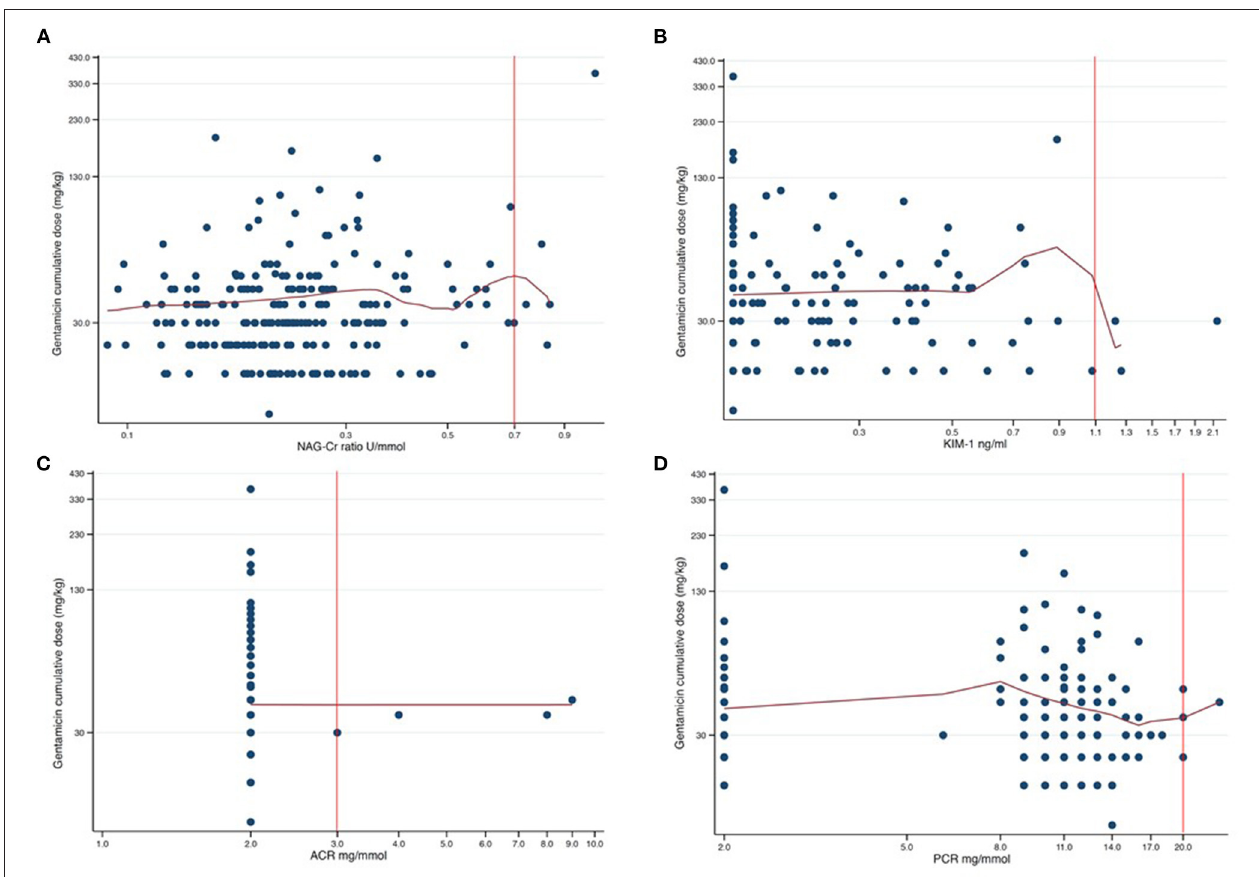
FIGURE 2 | Scatter plots of cumulative dose gentamicin against each of the four assessed urine biomarkers presented in a log-log graph. The red curves are the results from non-parametric kernel regression for the relationship between the cumulative dose of gentamicin and the urine biomarkers. The y-axis shows the cumulative dose of gentamicin in mg/kg with 100 mg/kg between axis ticks in each of the plots. The red vertical lines are the respective cutoff values for abnormal urine biomarker levels. The tick markers for the x-axes are evenly spaced but appear unevenly spaced since the axes are logarithmic. The distance between axes ticks is chosen so that, in each plot, one tick marker coincides with the cutoff value (red vertical line). (A) NAG-Cr (U/mmol) on a logarithm scale, with the distance between the tick markers for the x-axis of 0.2 U/mmol. (B) KIM-1 (ng/ml) on a logarithm scale, with the distance between the tick markers for the x-axis of 0.2ng/ml. (C) ACR (mg/mmol) on a logarithm scale, with the distance between the tick markers for the x-axis of 1.0 mg/mmol. (D) PCR (mg/mmol) on a logarithm scale, with the distance between the tick markers for the x-axis of 3.0